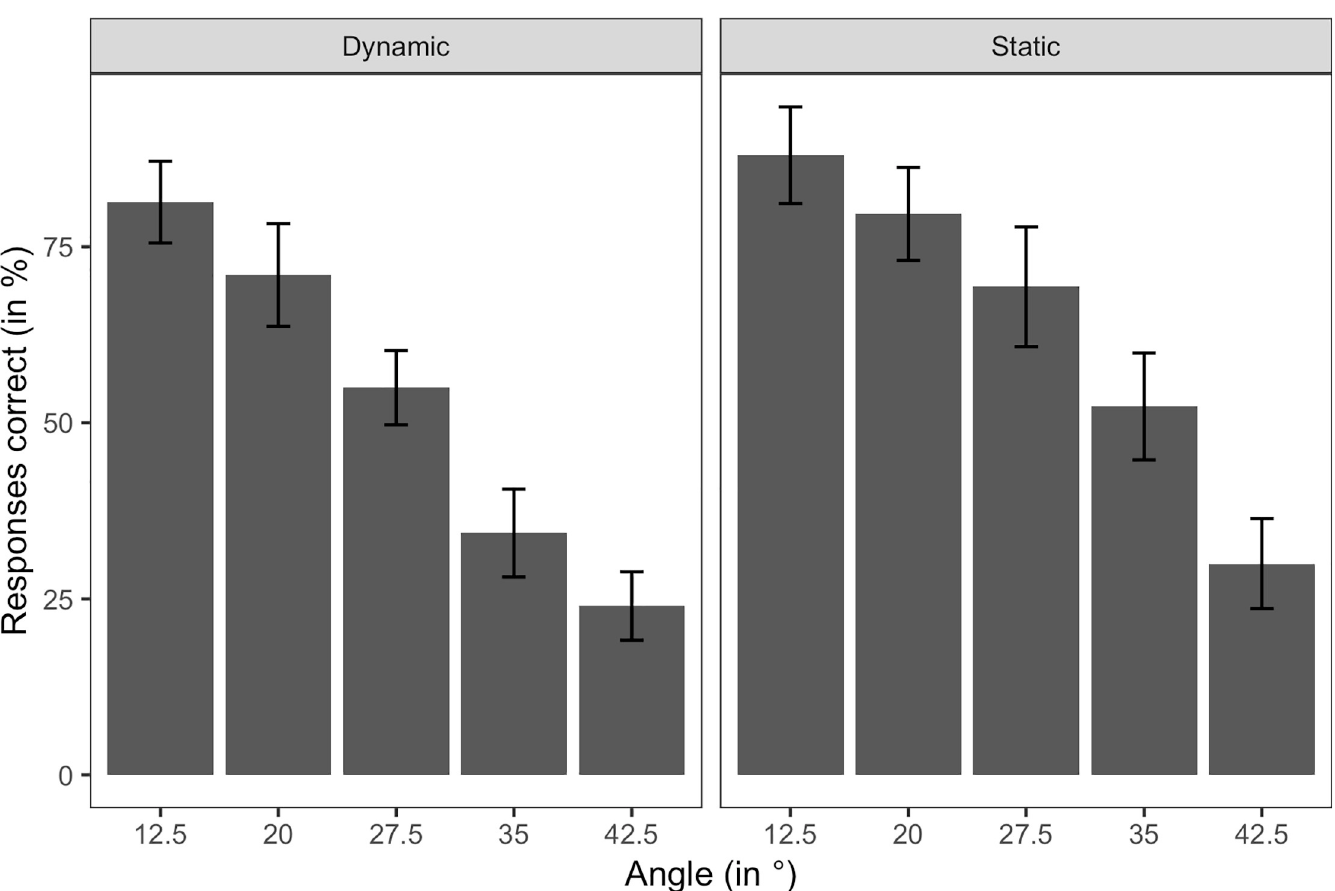
Fig 2. Mean response accuracy per angle. Bars indicate the proportion of correct responses. Error bars provide 95% confidence intervals.